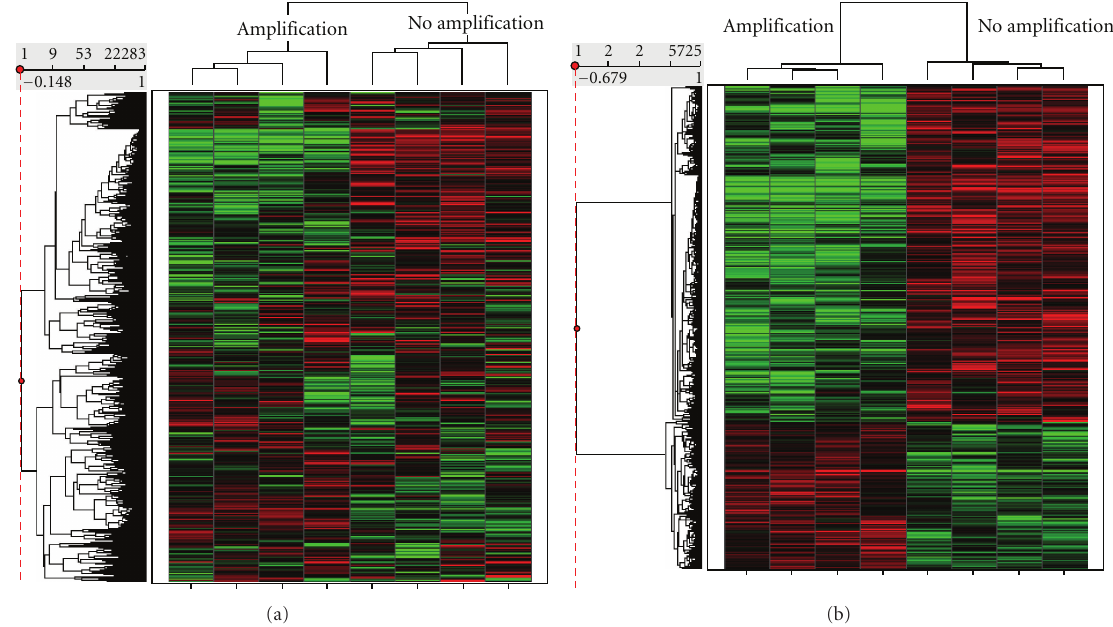
Figure 2: Unsupervised (a) and supervised (b) hierarchical cluster analysis of microarray results from non amplified and amplified RNA samples from colorectal carcinoma samples.